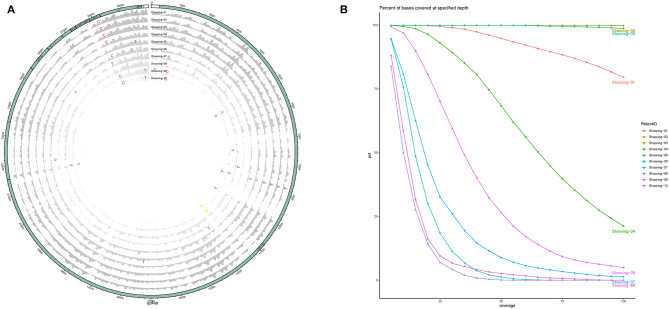
Coverage and depth. (A) Coverage and depth map. Normalized depth at each position along the genome are shown for each sample, with SNPs marked by the alternate allele. (B) Depth ratio. The X-axis plots the log value of the depth for each genome while the Y-axis plots the cumulative percentage of bases covered to the specified depth.